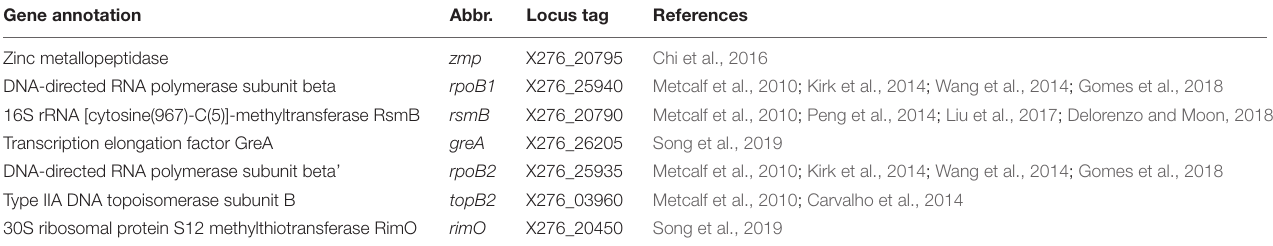
TABLE 3 | Candidate reference genes of C. beijerinckii NRRL B-598.